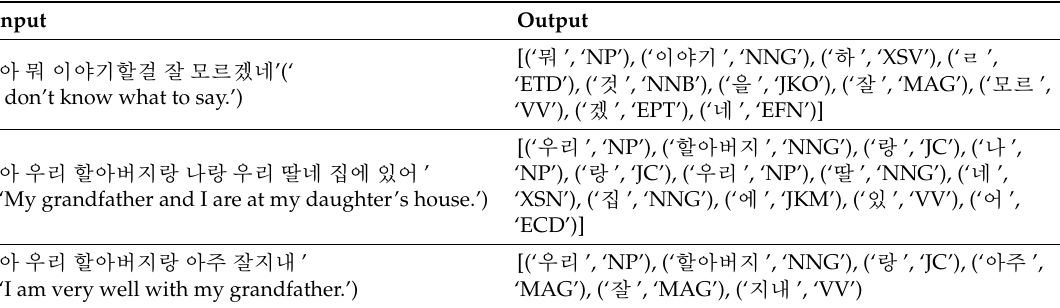
Table 2. Results of analyzing sentences using a morphological